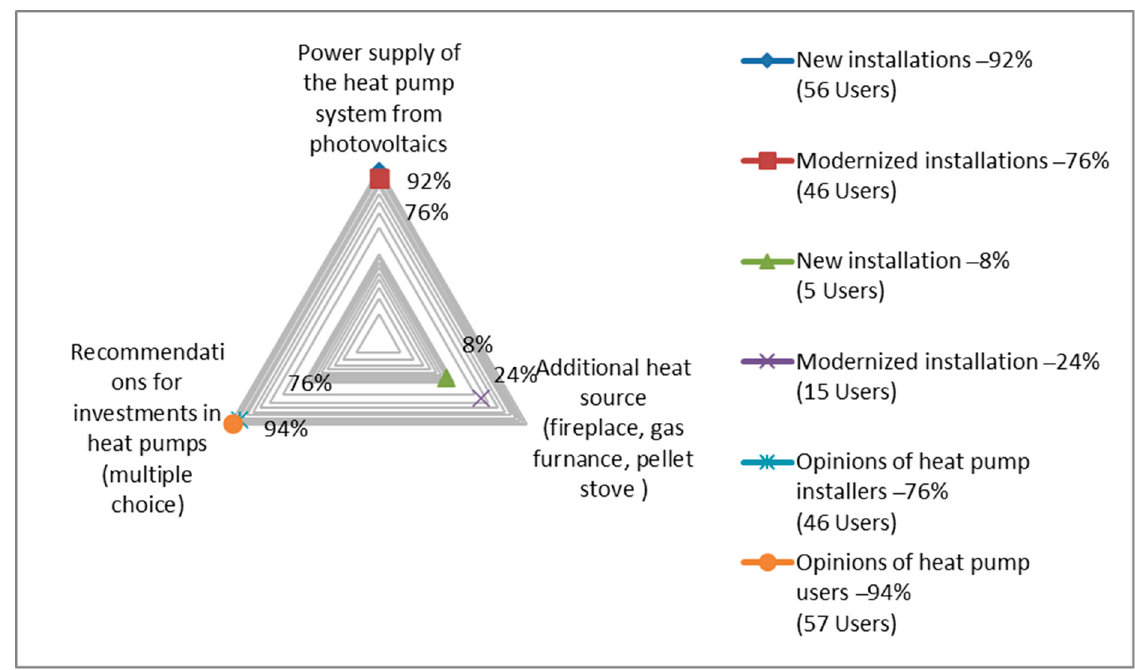
Figure 2. Analysis of power sources/support for heat pump installations and user satisfaction with heat pump installations—summary of research results.